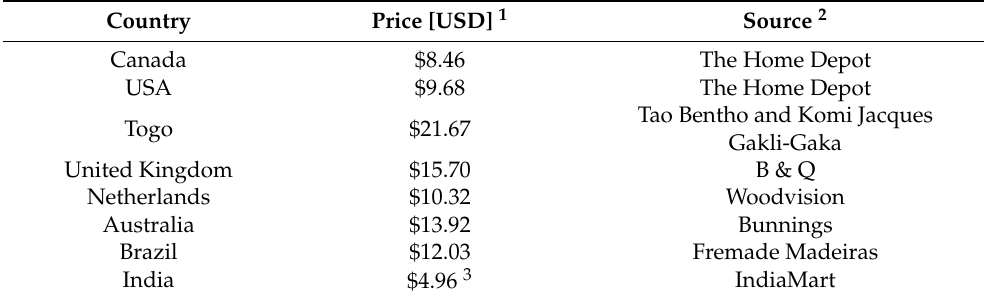
Table 8. The typical price of a pressure treated 2 × 4 × 8 in various countries converted to USD